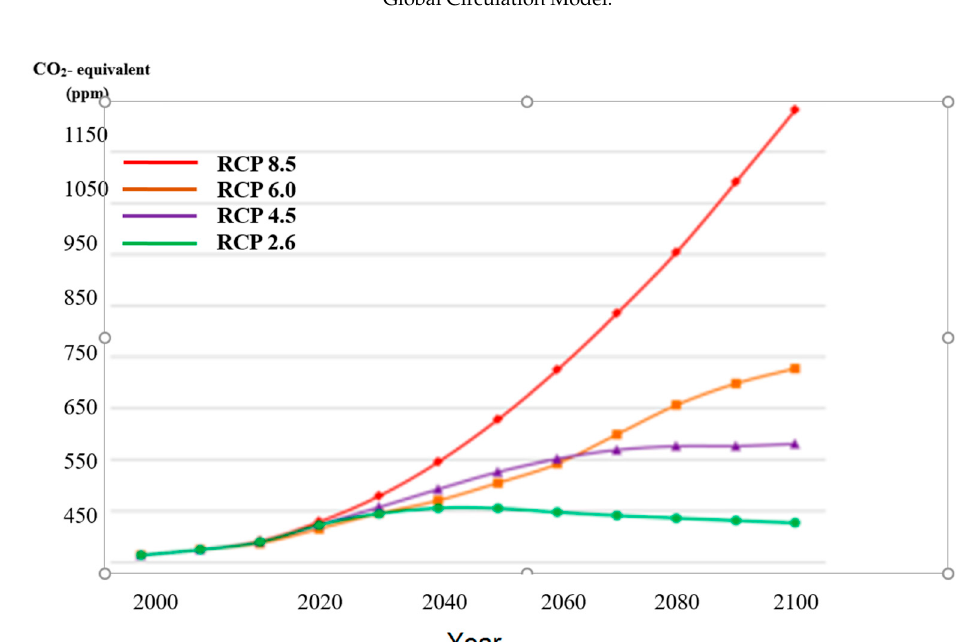
Figure 1. Estimated future equivalent atmospheric CO 2 concentrations including all ‘forcing’ agents according to the four representative concentration pathways (RCPs).